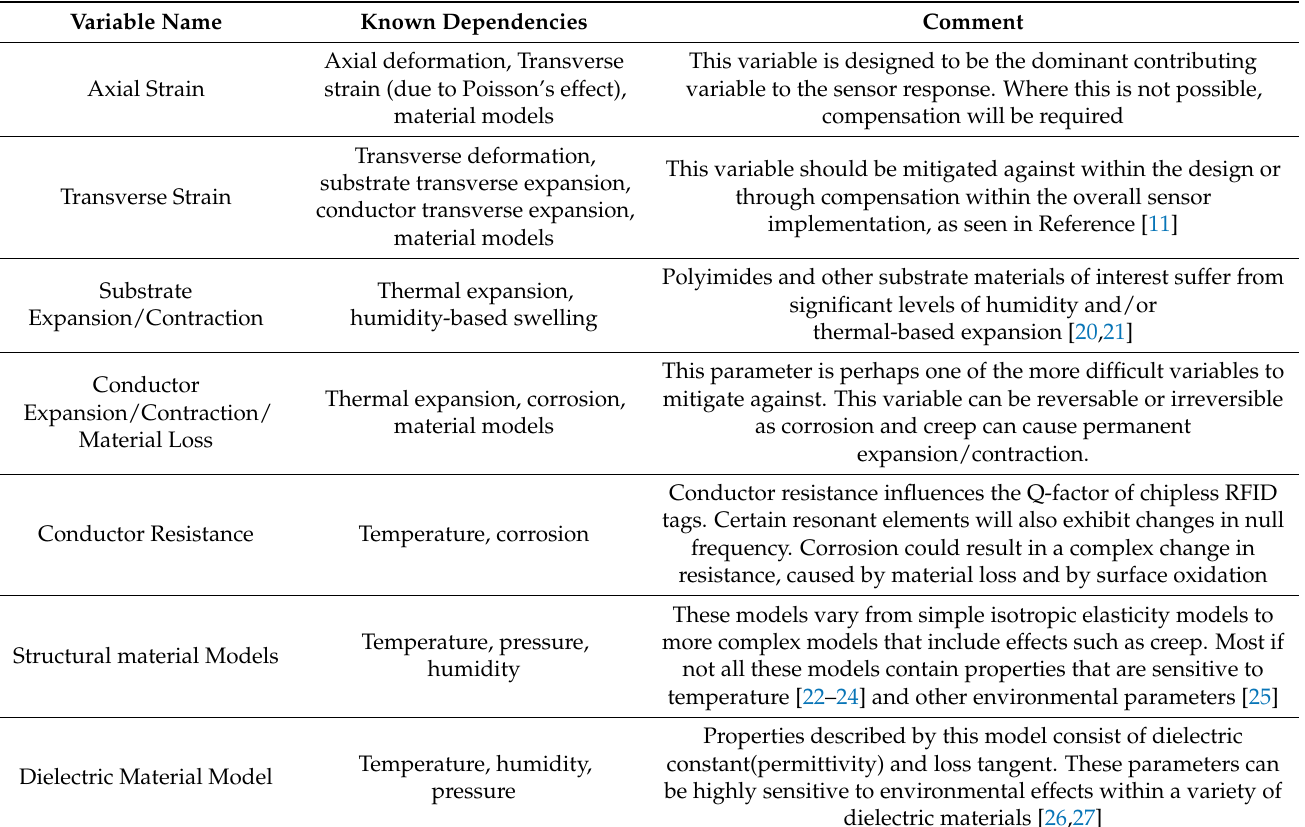
Table 1. Resonator Sensitivity